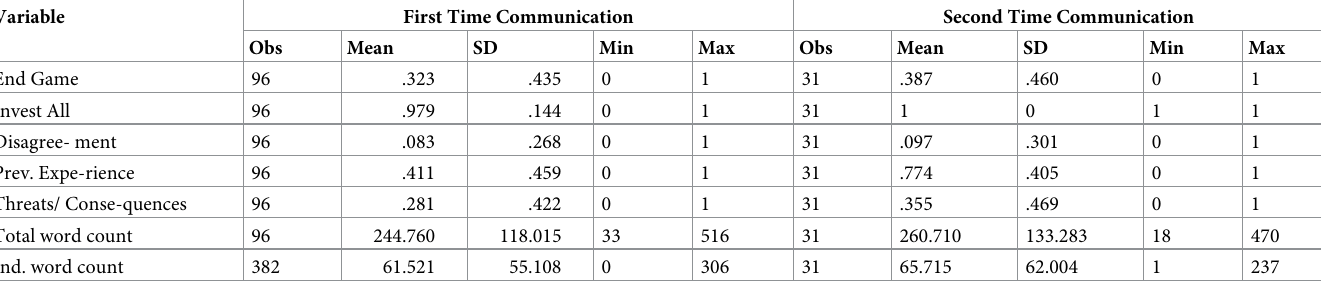
The values for content parameters stem from two coders and are normalized to 1. Thus, the mean value denotes the percentage of cases in which the respective variable was identified by coders. We provide the observation numbers on group level in all categories but the last one (individual word count). There, observations are coded on the individual